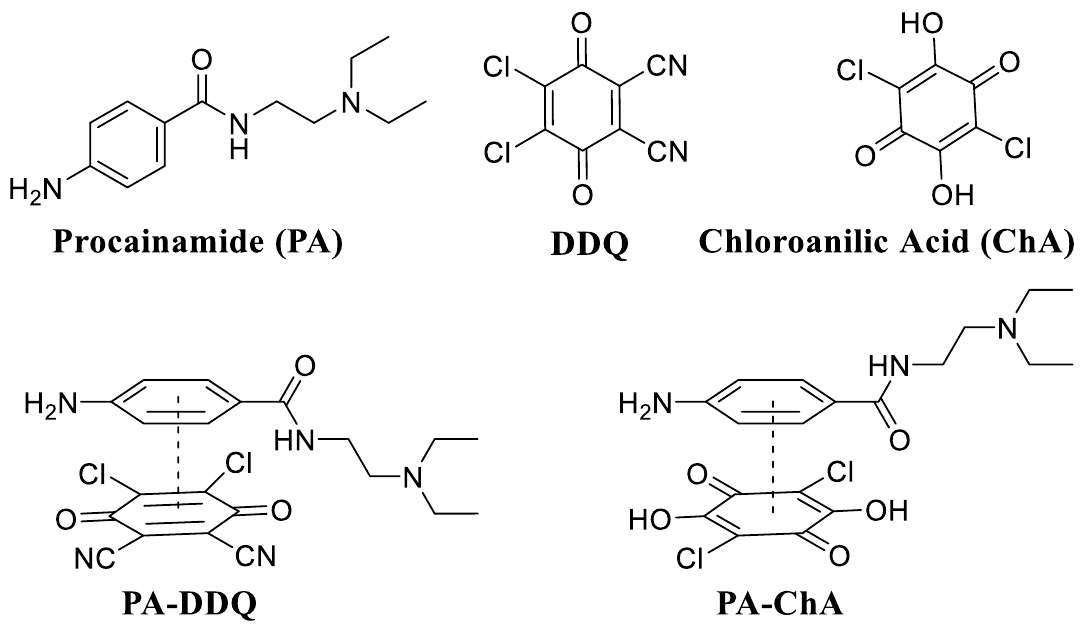
Figure 1. Chemical structures of procainamide and its complexes.